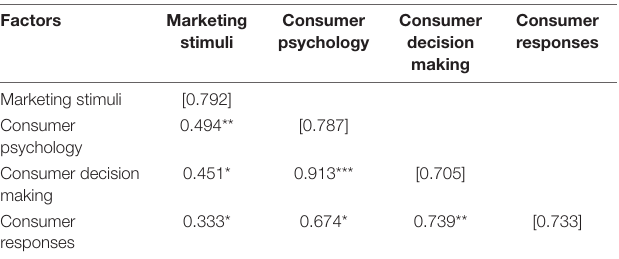
TABLE 3 | Factor correlations and discriminant validity.